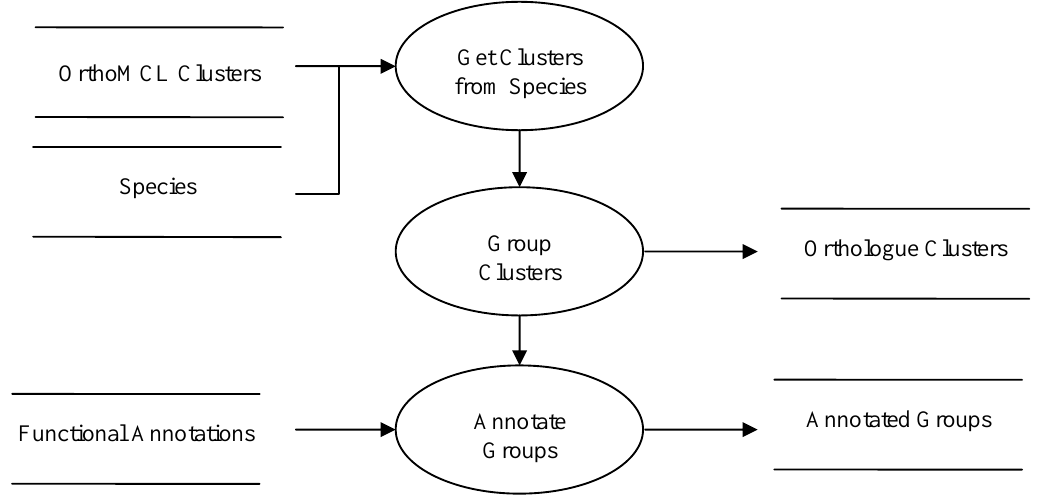
Figure 4: A data flow diagram for conservation and